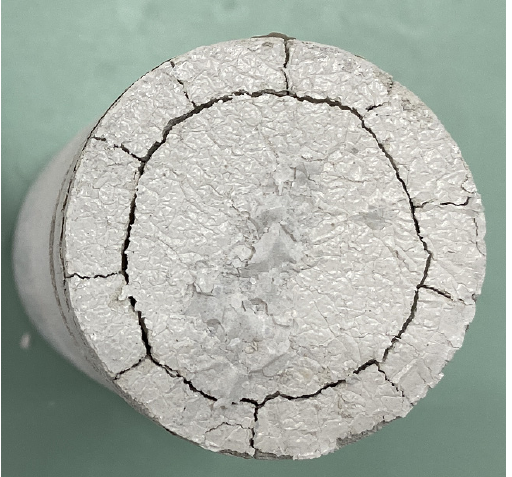
Figure 4. Contraction cracking caused by high water content.